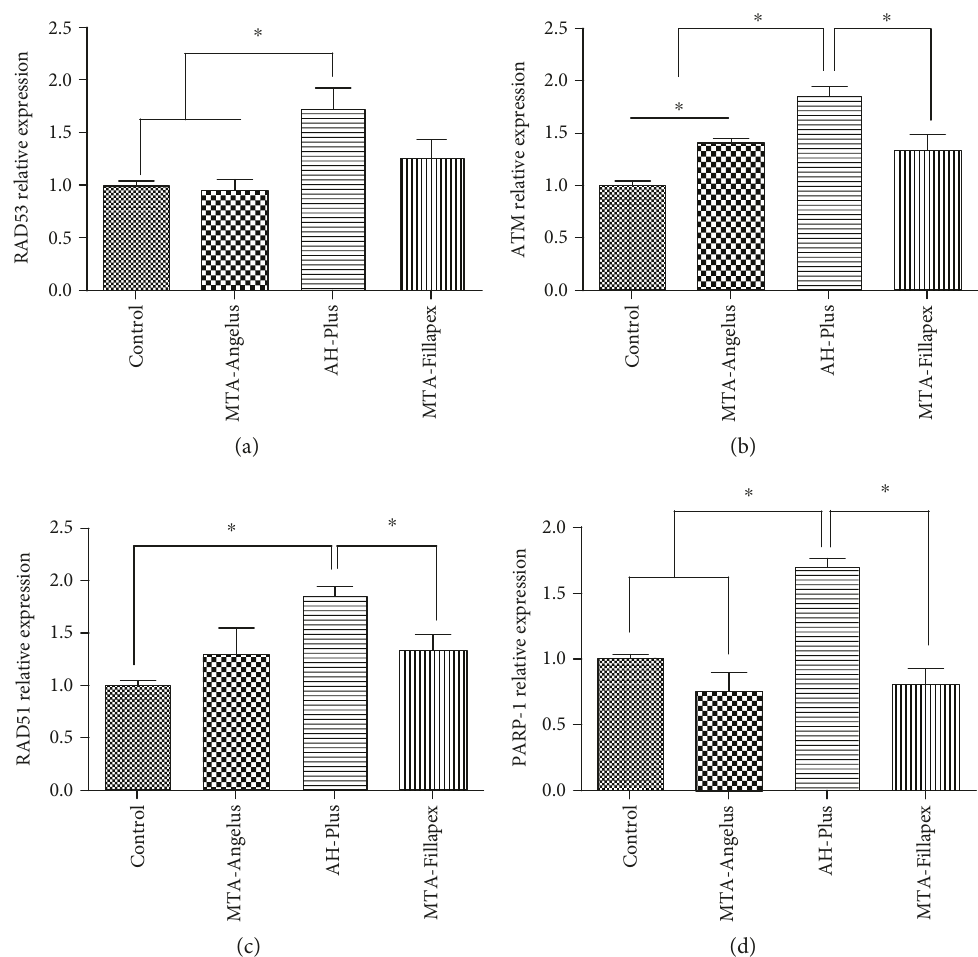
Figure 3: Analysis of expression of DNA damage responses and repair genes in HDPSCs incubated with endodontic materials at 24hours, by the technique of real-time polymerase chain reaction (qRT-PCR) for (a) RAD53, (b) ATM, (c) RAD51, and (d) PARP-1. The statistical test used was ANOVA with a post hoc Newman-Keuls test to analyze changes in the relative expression of DNA damage response and DNA repair genes. ∗ indicates signi fi cant di ff erences between groups compared ( p < 0 05 ). Each sample was analyzed in